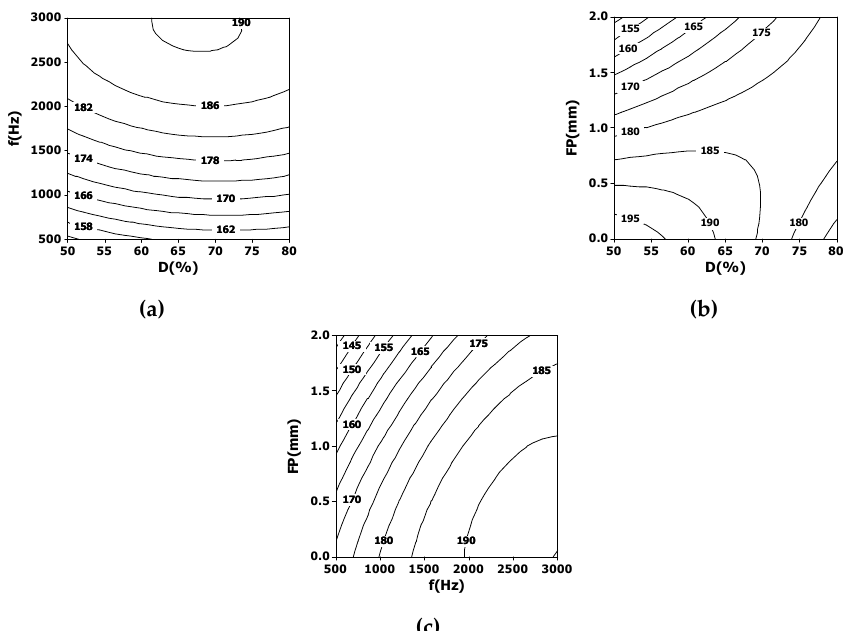
Figure 4. Contour plots showing the interdependence of some laser processing parameters, namely: ( a ) duty cycle and frequency; ( b ) duty cycle and focus position; ( c ) focus position and frequency, on the average exit diameter (in microns).